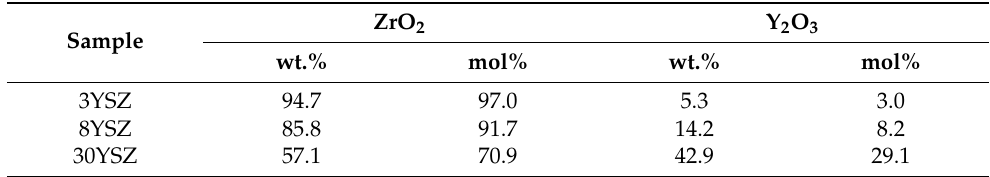
Table 1. Compositions of the YSZ nanospheres as determined by WDXRF.